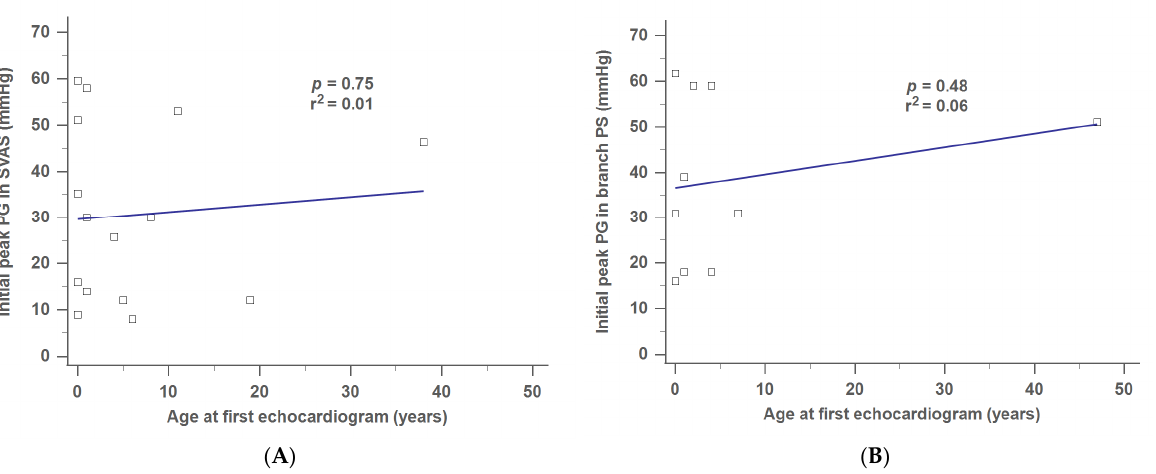
Figure 2. Changes in the mean peak velocity of overall ( A ), mild ( B ), moderate ( C ), and severe ( D ) branch PS at the initial echocardiography. The interval was presented as the median value. echoCG, echocardiography; PG, pressure gradient; PS, pulmonary stenosis. * p -value was calculated using the Wilcoxon signed-rank test. Figure 3A,B show that the initial peak PG was positively correlated with age at first echocardiogram in the cases of SVAS (Figure 3A) and branch PS (Figure 3B). However, no